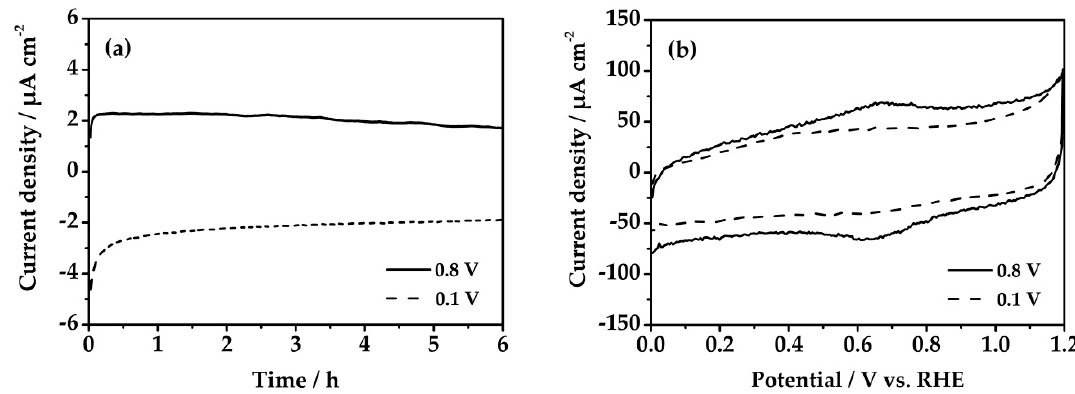
Figure 8. ( a ) Current density over time and ( b ) CVs after anodic (0.1 V) and cathodic (0.8 V) conditions after aging for 100 hours at 160 °C in 15 M H 3 PO 4 . Electrochemical measurements were done in 15 M H 3 PO 4 at room temperature.